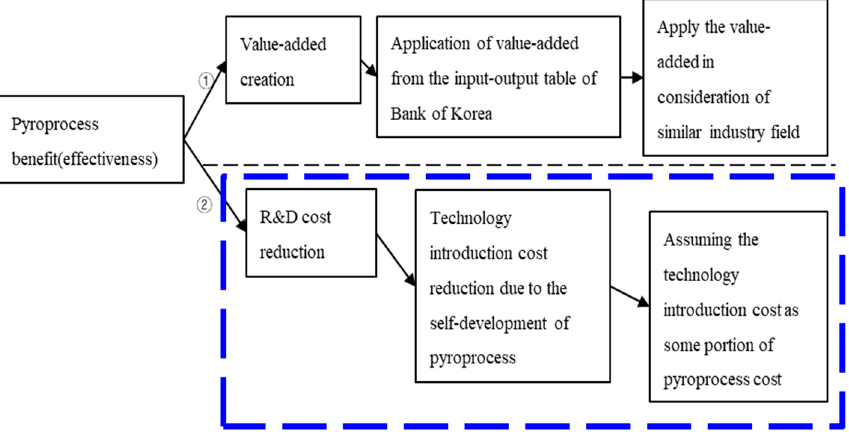
Figure 4. Pyroprocessing benefits (effectiveness).